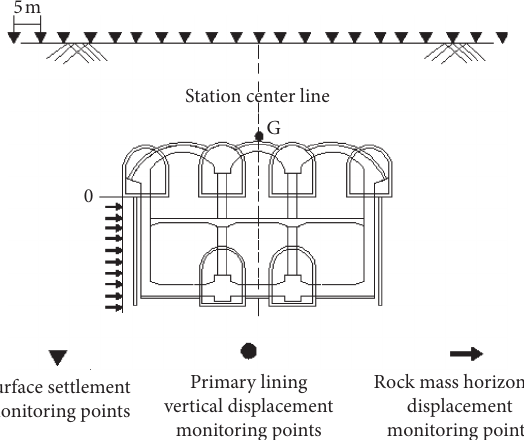
Figure 9: Diagram of the location of the monitoring points.